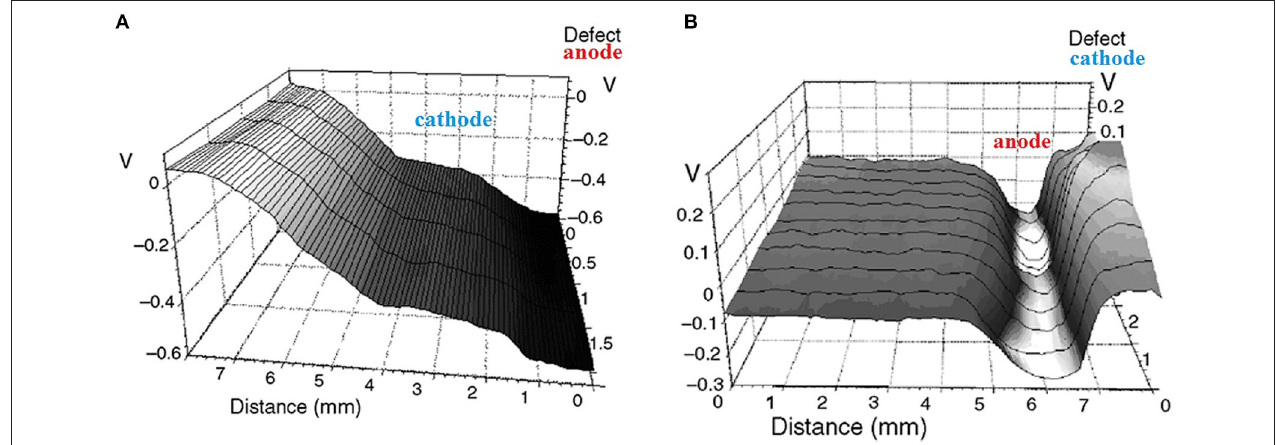
FIGURE 7 | Potential distribution (V vs. SHE) of a coated steel with a linear defect (right-hand side) in the epoxy vinyl coating (100 µ m thick). (A) Measurement with a thick layer of aqueous electrolyte in the defect. (B) Measurement of the same area with a thin electrolyte layer during atmospheric corrosion at 95% RH. Reprinted with permission from NACE International ( Nazarov and Thierry,